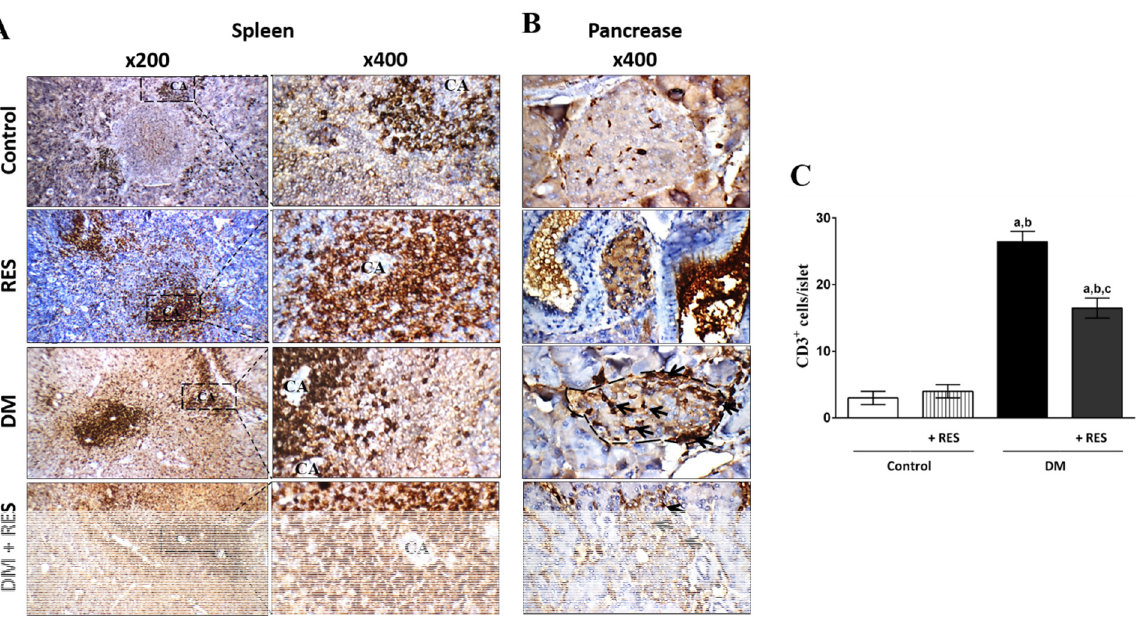
Figure 7. ( A ) Spleen of STZ-treated mice shows marked increase in CD3 positive cells in peri-arte- riolar area in certain follicles and high reactivity in red bulb area in comparison with the average positive cells for CD3 in peri-arteriolar area (T-cell area) with mild reactivity in red bulb in normal spleen of the control or RES groups. However, STZ-injected group in the presence of RES displayed spleen with average positive cells for CD3 in peri-arteriolar area and mild reactivity in red bulb area (400 X and 200 X) compared to STZ-treated group; ( B , C ) Normal and RES-injected animals show normal number of positive cells for CD3/ islet. Pancreatic islets from STZ-injected mice display marked increase in CD3 positive cells/islets in comparison with normal animals. Diabetic group injected with RES reveals marked decrease in positive cells for CD3/islets in comparison with STZ-injected animals, as shown by immunohistochemistry and the average count of T-cells/islets for all treated groups (400 X). Data represent mean ± SEM; a difference is significant compared to control group; b difference is significant compared to RES group; c difference is significant compared to diabetic group at p < 0.05.